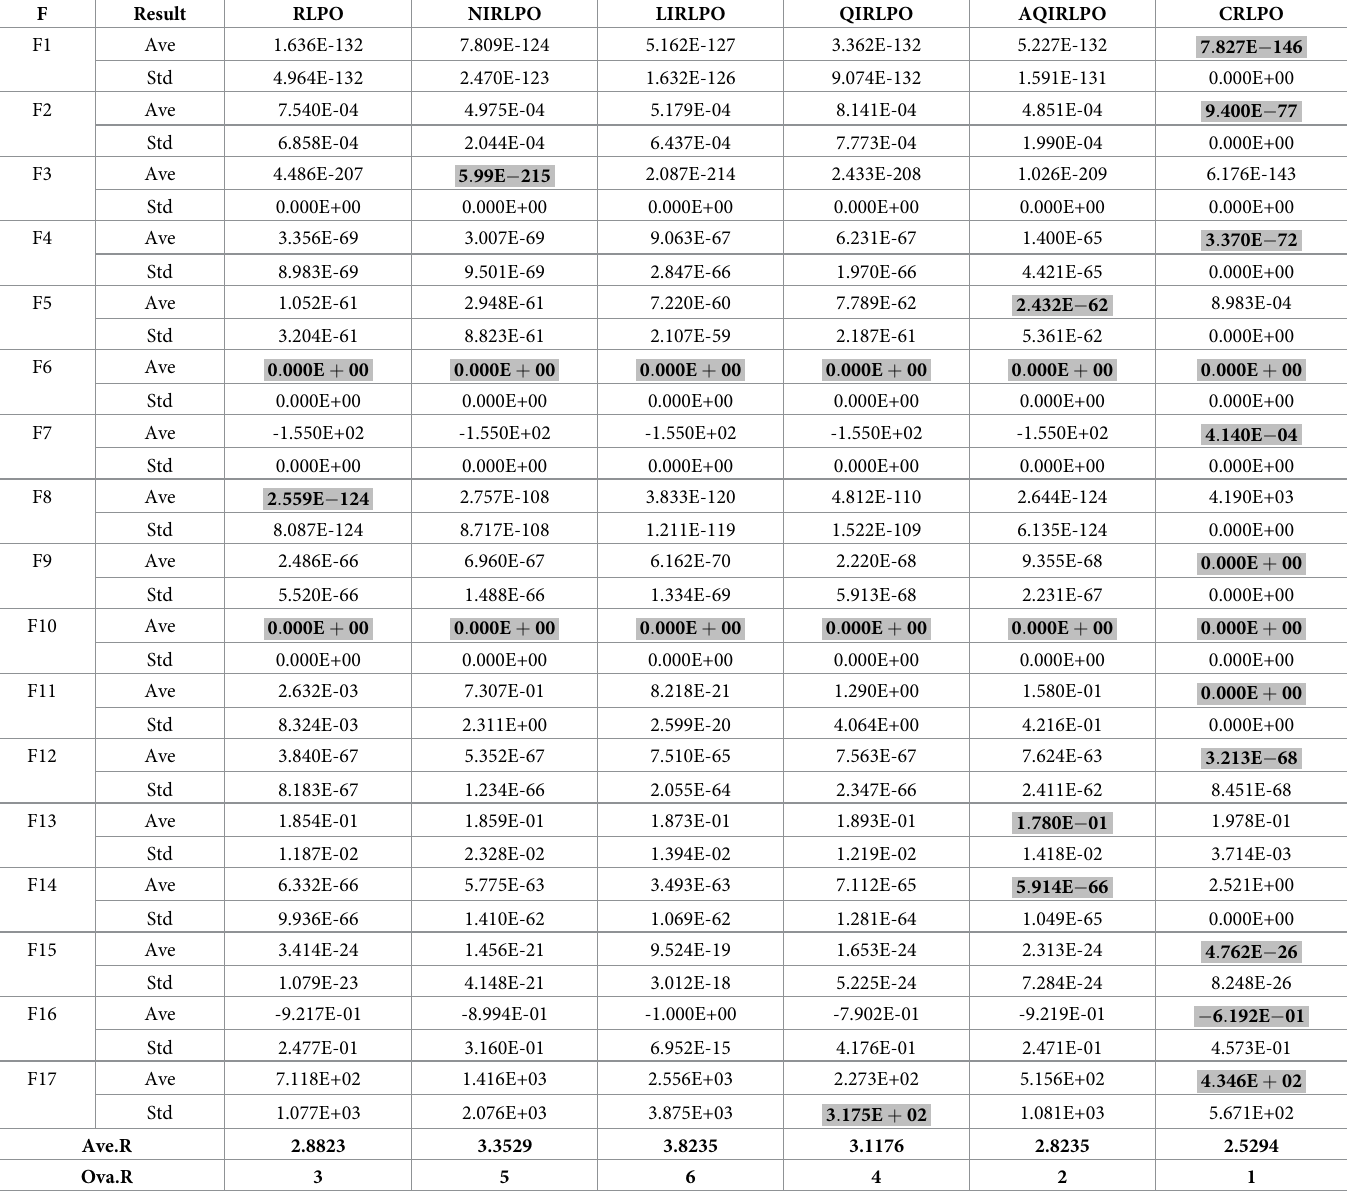
Table 14. Experimental results of RLPO with various interpolation strategies on 17 test functions from [51] (Dim = 30). F Result